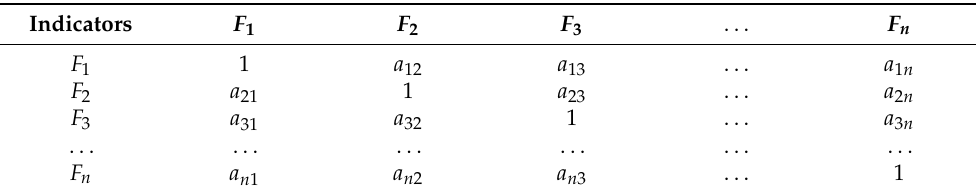
Table A7. Judgment matrix model.